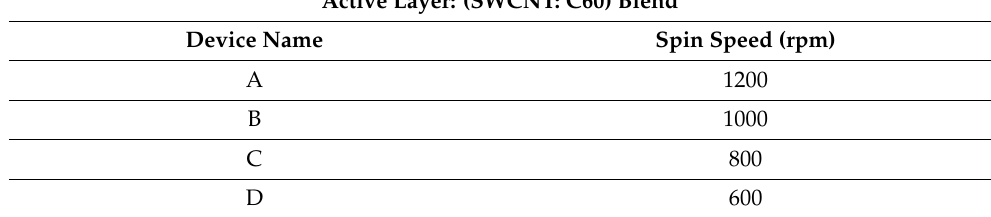
Table 3. Active layer coating with different spin speed.